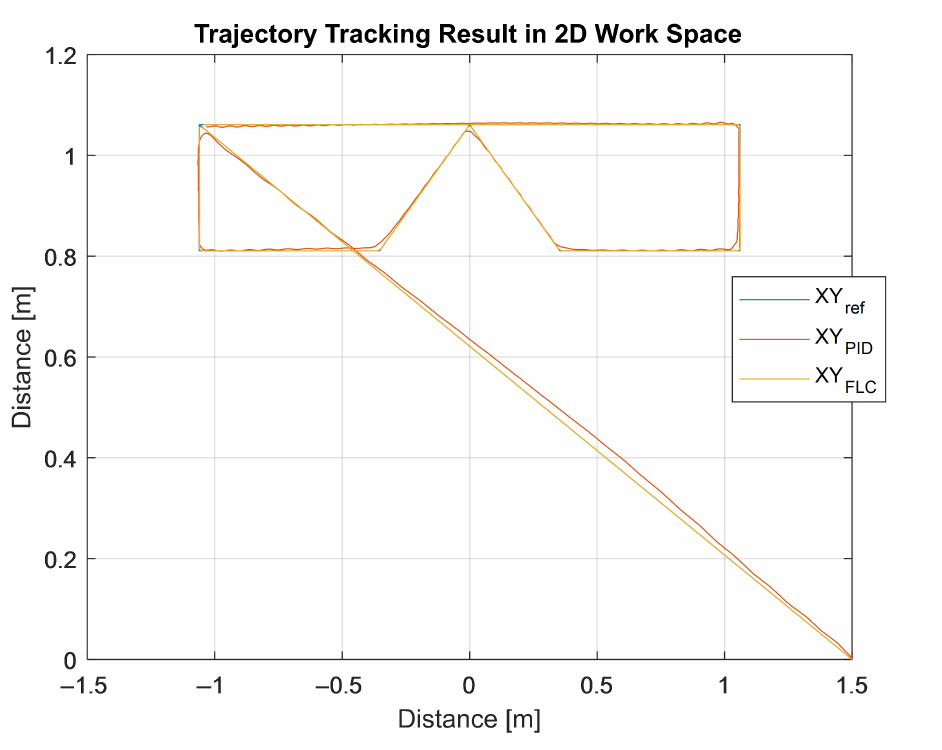
Figure 13. Obtained trace on end-effector work plane.